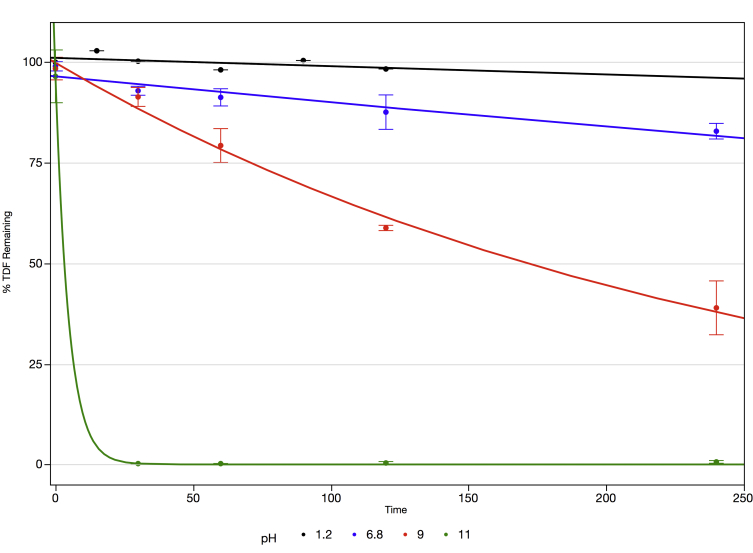
pH stability of TDF. About 1 mM TDF was incubated in triplicate at 37°C in SGF at pH 1.2 (black line) and in FaSSIF at pH 6.8 (blue line), 9 (red line), and 11 (green line). TDF was quantified by LC-MS/MS.